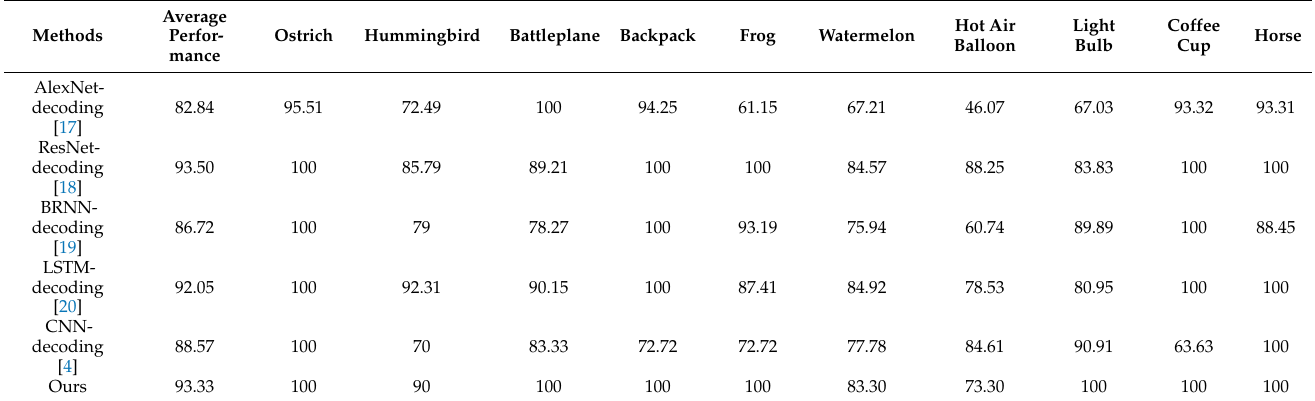
Table 4. Comparison of experimental results (precision, %).